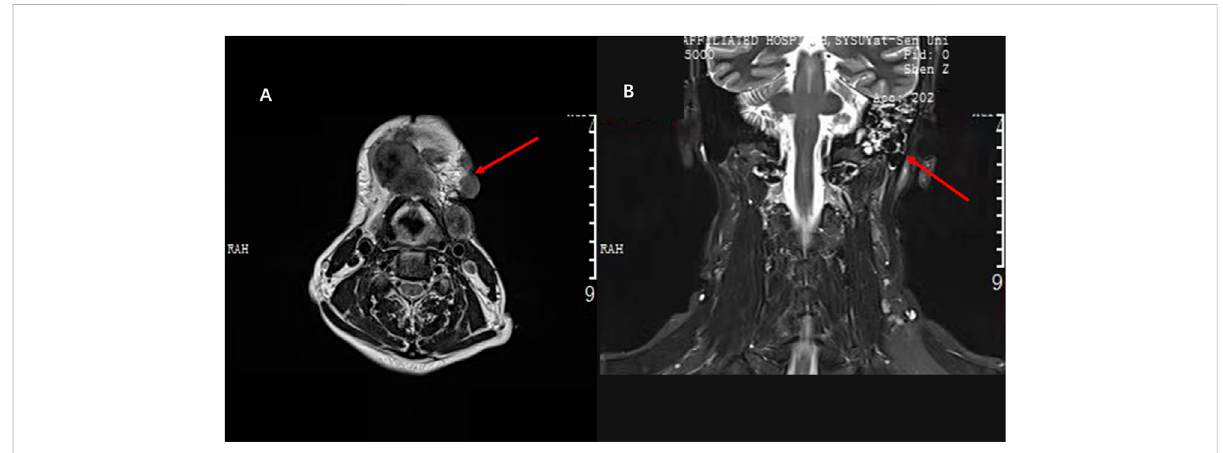
FIGURE 3 MRI image of metastatic melanoma. (A) T2-weighted axial image shows soft tissue mass with ill-de fi ned borders involving the left lateral wall and cervical lymph node metastasis. The lesion is causing compression of oropharynx. (B) Post contrast T2-weighted coronal image shows the enlarged cervical lymph node.